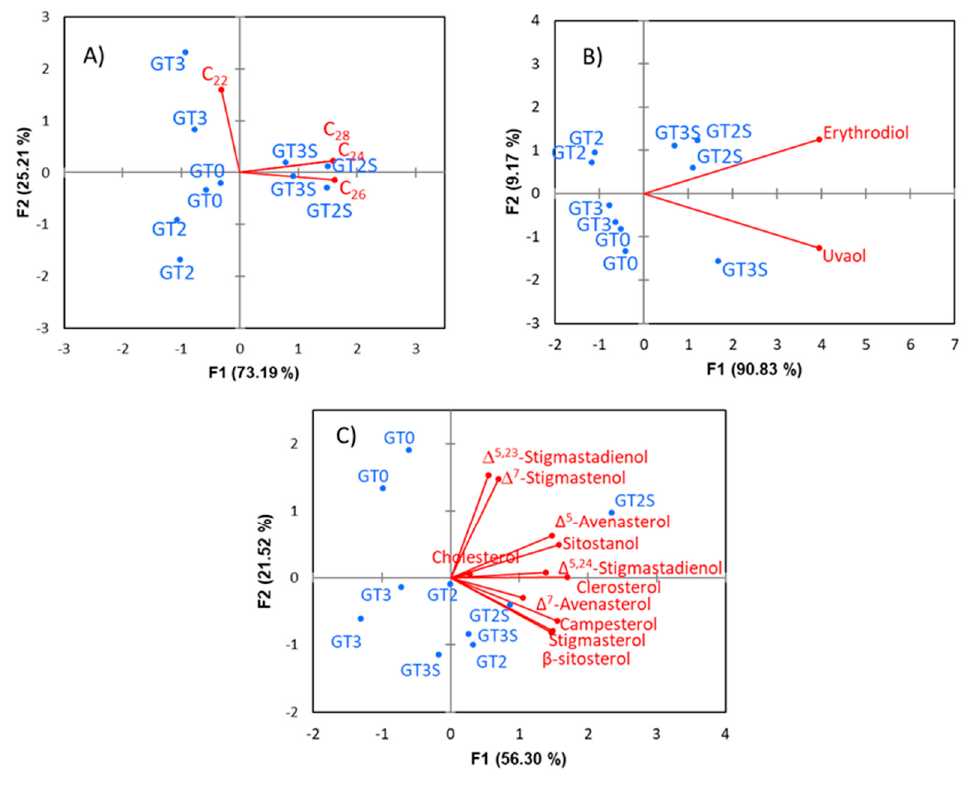
Figure 6. A study, based on the original data, of the changes according to processing phases and extraction method in the minor components in green Spanish-style fat using Multiple Factor Analysis (MFA): PCA was done according to minor component groups. Fatty alcohols ( A ), triterpene dialcohols ( B ) and sterols ( C ). GT0, GT2 and GT3 are oils extracted from the fresh, fermented and packaged olives, respectively. Samples coded S were extracted by Soxhlet; otherwise, they were extracted by Abencor.